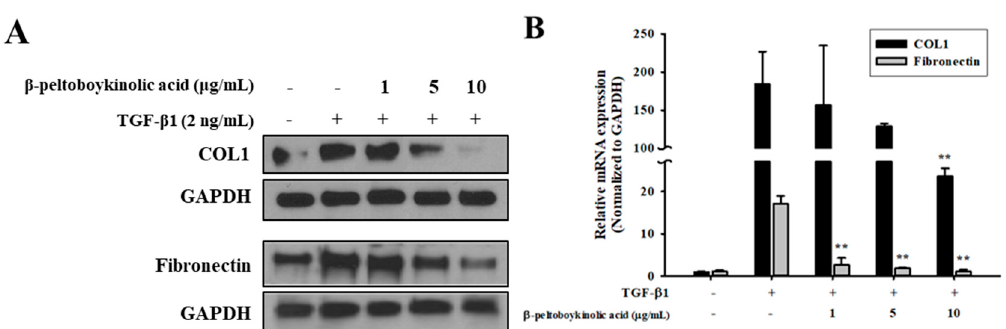
Figure 5. Inhibitory effect of β -peltoboykinolic acid on extracellular matrix (ECM) production induced